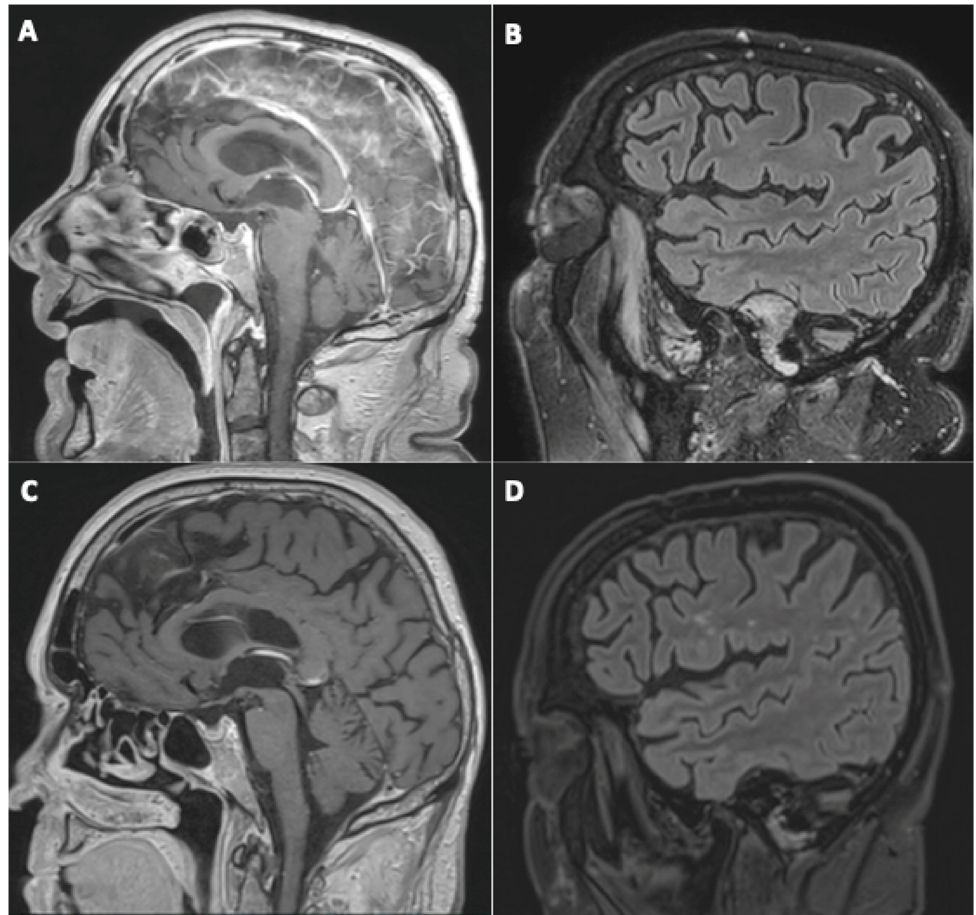
Figure 2. A 79-year-old man (#21) initially hospitalized (ICU) ( A , B ), who underwent a second MRI during follow-up 112 days later ( C , D ). Sagittal post-contrast three-dimensional T1-weighted spin- echo MR imaging ( A , C ) and sagittal FLAIR MR images ( B , D ). Basilar artery wall enhancement ( A ) with normalization of the vessel wall imaging during follow-up ( C ), and appearance of white matter FLAIR hyperintensities, presumed of a vascular origin ( D